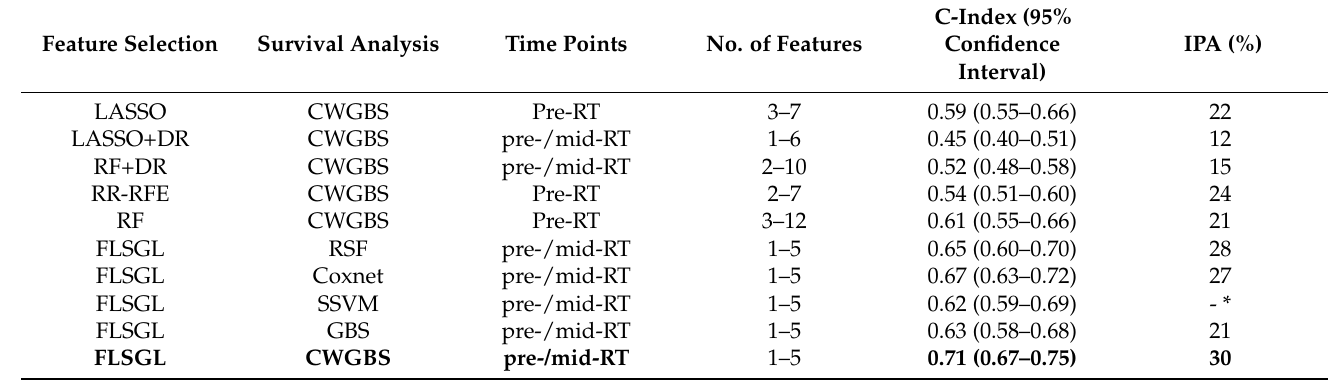
Table 4. Comparison of FDG PET radiomics overall survival prediction models between the proposed FLSGL and CWGBS with different feature selection and survival regression models (DR—delta radiomics; Coxnet—Cox net survival model; RR-RFE—ridge regression recursive feature elimination; RF—random forest; FLSGL—fused Laplacian sparse group LASSO; RSF—random survival forest; GBS—gradient boosting survival; SSVM—survival support vector machine; CWGBS—component- wise gradient boosting survival). Bolded values denote highest level of performance.